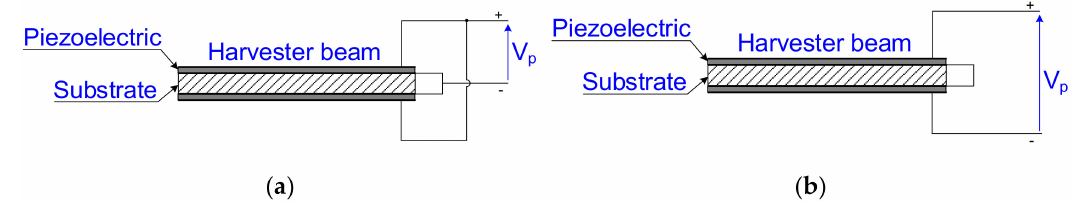
Figure 1. Electric connections of two piezoelectric layers in bimorph: ( a ) parallel; ( b )